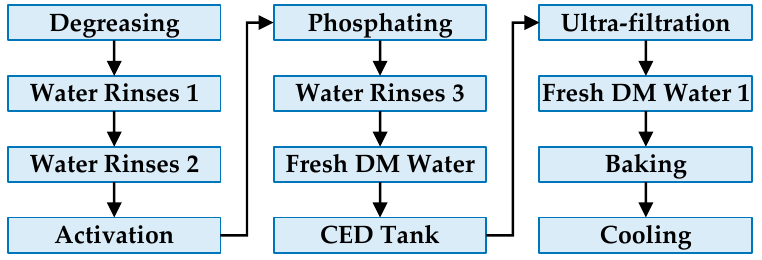
Figure 3. Flow diagram—Preparation of electrodeposition (ED)coating.